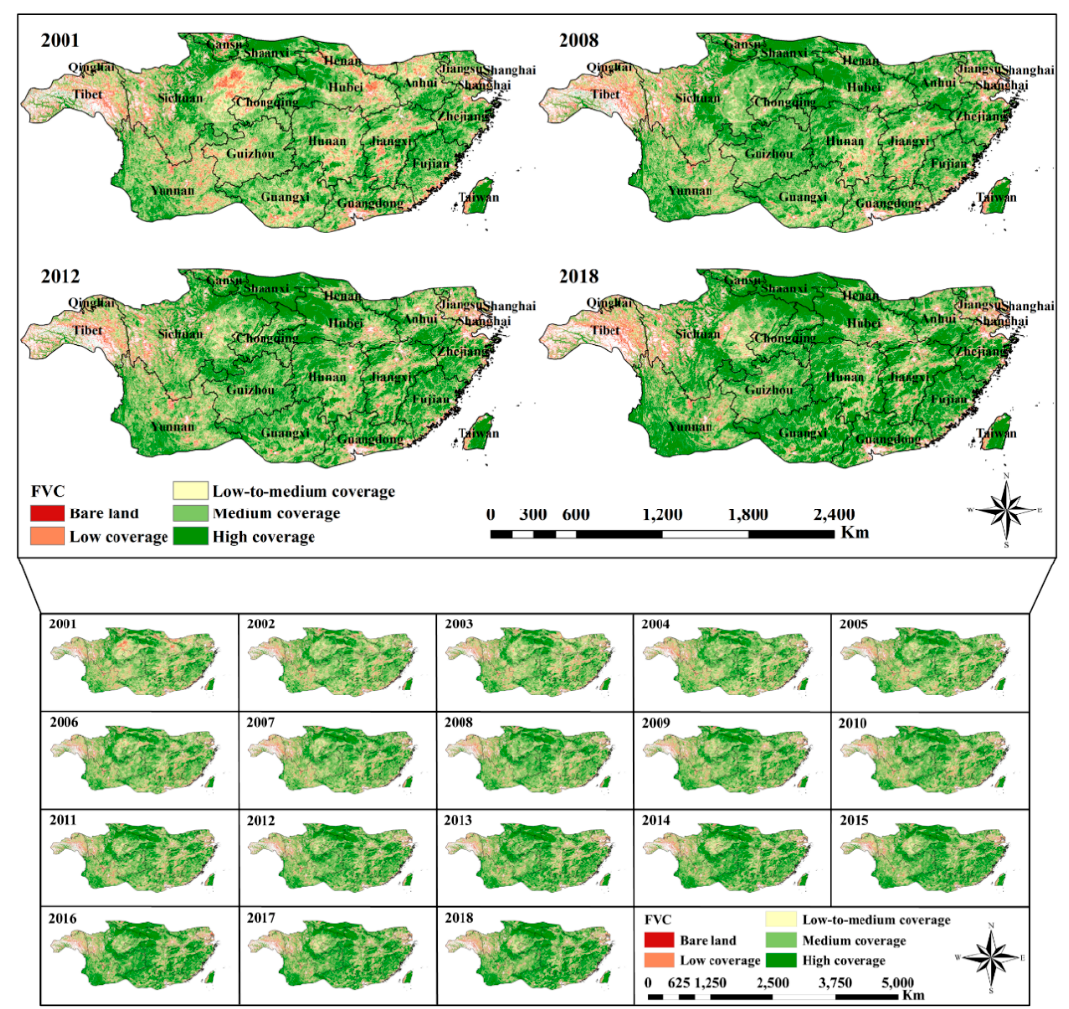
Figure 2. Spatial distribution of the subtropical fractional vegetation cover (FVC) from 2001 to 2018.